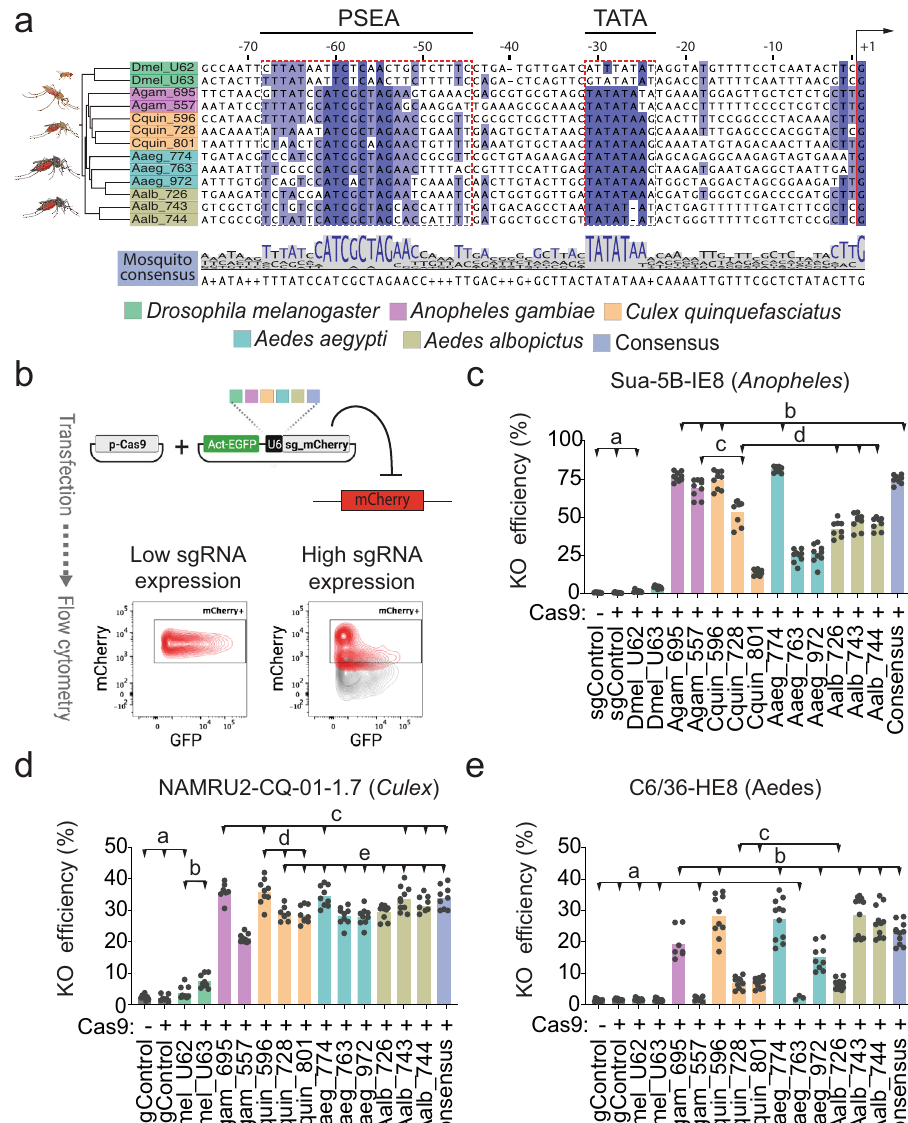
Fig. 3 Identi fi cation of U6 promoters for sgRNA expression in mosquito cells and evaluation of CRISPR KO ef fi ciency. a Multiple alignments of selected U6 promoters highlighting the metazoan pol III promoters bipartite structure and a mosquito consensus sequence. The fi rst transcribed base of the U6 snRNA, the TATA box, and proximal sequence element A (PSEA) are boxed in red. The consensus sequence derived from mosquito sequences was used to design a synthetic U6 promoter. b Flow cytometry-based assay for evaluation of CRISPR KO ef fi ciency with different U6 promoters. Engineered mosquito cells expressing mCherry were co-transfected with a plasmid expressing Cas9 and a GFP reporter plasmid expressing the sgRNA targeting mCherry under the control of different U6 promoters. After transfection, cells were passaged for up to 12 days and then analyzed by fl ow cytometry. Only GFP + cells were considered in the analysis. Relative KO ef fi ciency was obtained by calculating the ratio of mCherry- cells over total GFP transfected cells. c – e Evaluation of U6 promoter-speci fi c CRISPR-KO ef fi ciencies in three mosquito cell lines. Histogram bars represent the mean, dots represent the distribution of multiple reps obtained from 3 independent experiments. Histogram colors denote the species of origin of the U6 promoters analyzed, shown with abbreviation of species name and three last letters of the corresponding Vectorbase gene ID. sgControl = pLib6.4-Agam_695 U6 expressing the empty BbsI cassette was used as control. Statistical analysis was performed using Brown-Forsythe and Welch ANOVA tests followed by Dunnett ’ s multiple comparison test. Lowercase letter groupings denote differences not signi fi cant ( P Dunnett > 0.05). All differences between samples of different groupings are signi fi cant ( P Dunnett < 0.05). Raw data, detailed descriptive statistics, and statistical analysis, including sample number and calculated P values for each comparison, are reported in Supplementary Data 2 and Source Data fi